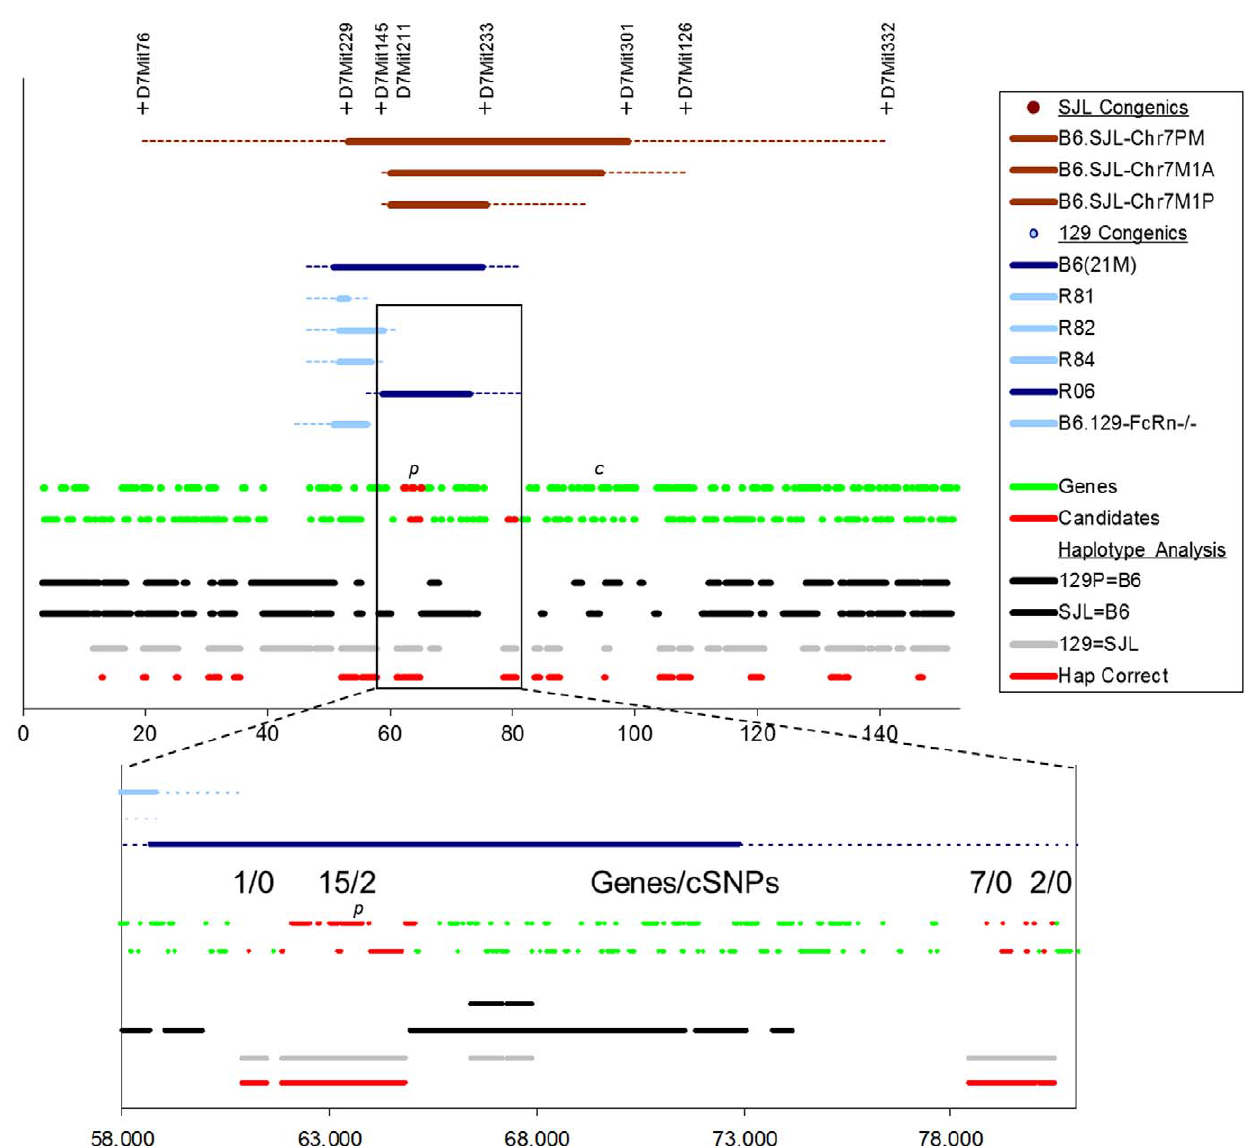
Figure 5. Mapping the region responsible for AngFq5 . Top: Location of the congenic regions for the congenic strains used is plotted, along with boundary-defining markers for SJL congenics (brown). Blue indicates 129 congenics, with dark blue indicating those congenics that demonstrate a statistically significant difference in angiogenic response. Genes are indicated next by which DNA strand they are coded by. Finally regions of shared haplotype are indicated colored by whether the parental strains have disparate (black) or shared (grey) alleles at AngFq5 . Below: Magnification of the region of interest defined by the R82 and R06 congenics. The number of genes, and genes bearing amino-acid altering polymorphisms (cSNPs), is indicated as are the locations of the pink-eyed dilution gene ( p ) and the tyrosinase gene ( c ). Scale is in Mbp on build 37.1 of mouse Chromosome